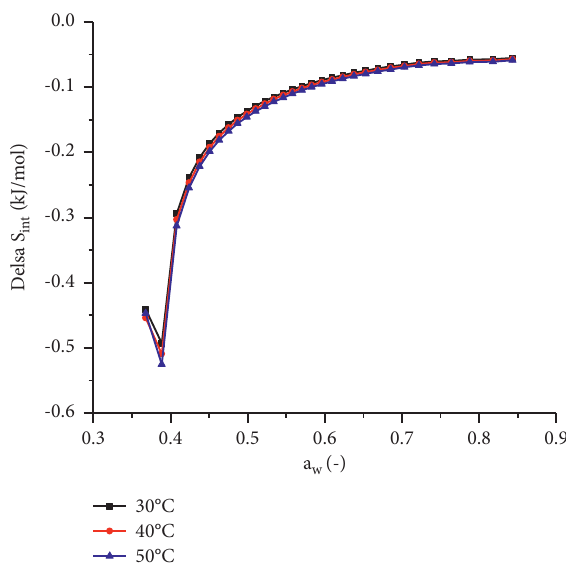
Figure 5: Integral entropy of SCP at temperatures of 30 ° C, 40 ° C, and 50 ° Table 3: Estimated parameters of models for SCP at different temperatures of adsorption curves. Models Parameters